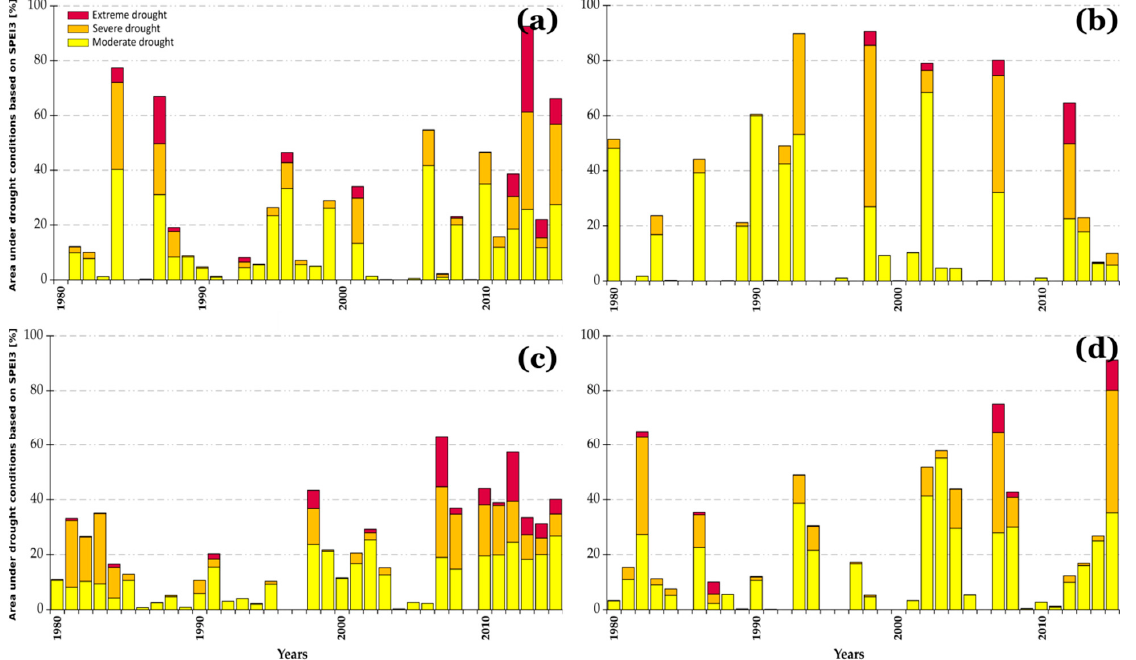
Figure 6. Same as Figure 5, but for the values of SPEI3 at: ( a ) February (DJF), ( b ) May (MAM), ( c ) August (JJA), and ( d ) November (SON).